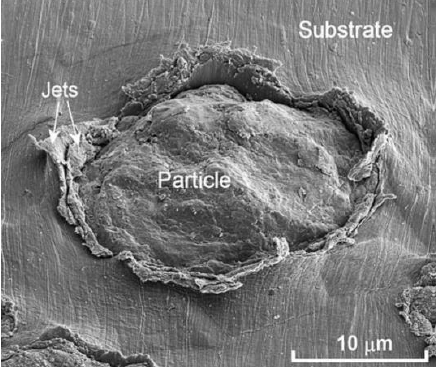
Figure 6. Example of cold-sprayed copper particle impact.